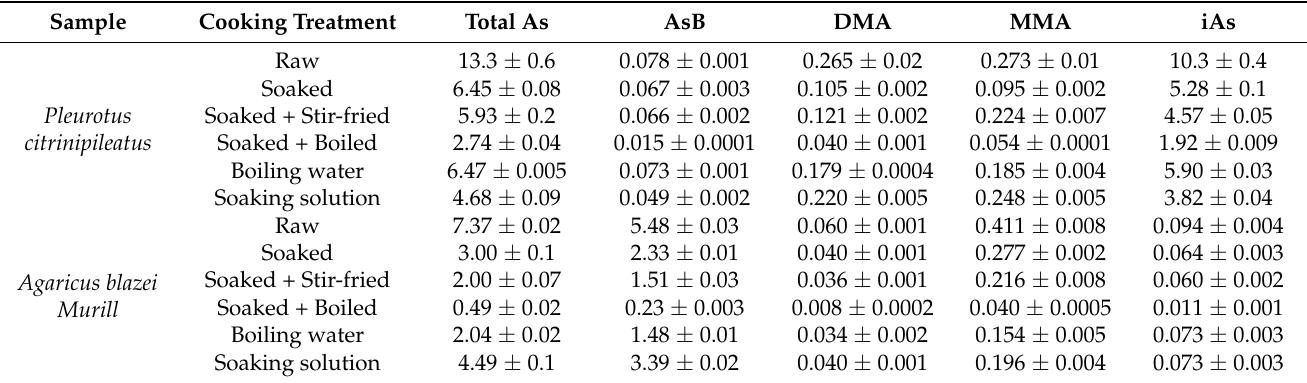
Table 2. Concentration of total As and its speciation in raw, soaked, stir-fried, and boiled edible fungus and in boiling water, soaking solution. Concentrations expressed as As mg kg − 1 dry mass (mean ± SD, n =